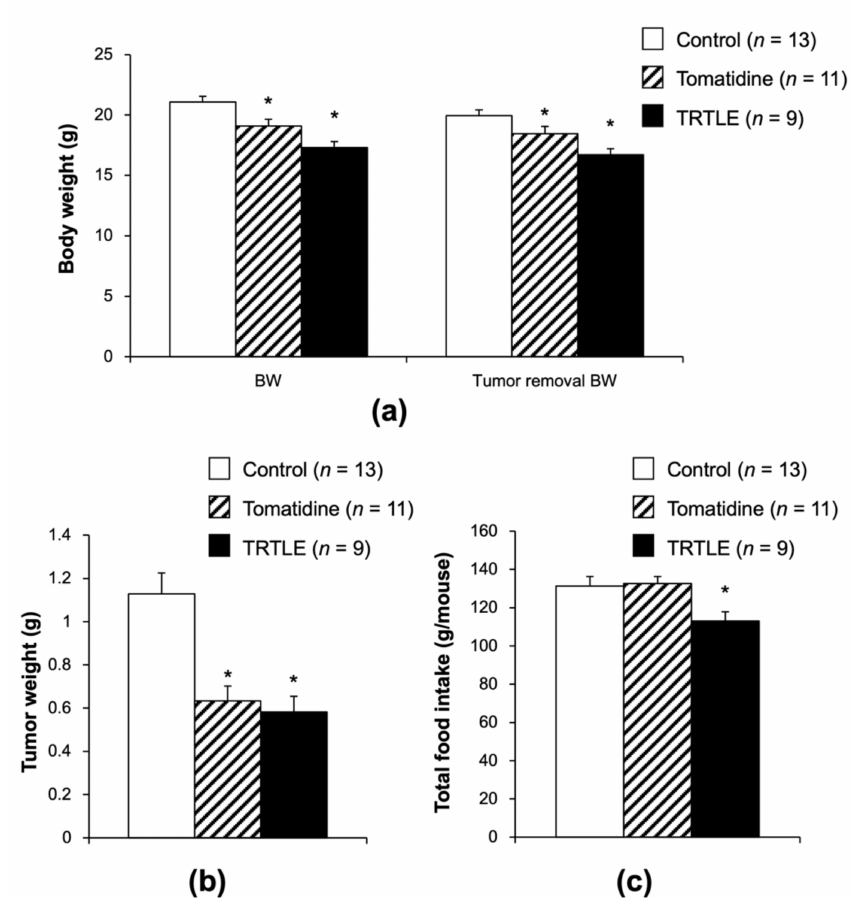
Figure 2. Effect of tomatidine and TRTLE on the tumor growth of an 85As2 syngeneic mouse model. Eight-week-old male BALB/c-AJcl-nu/nu mice were subcutaneously injected with 85As2 cells derived from human gastric cancer tissues. The mice were fed control diets (Control) or diets containing tomatidine (Tomatidine) or TRTLE (TRTLE) for 3 weeks. ( a ) Body weight (BW), BW after tumor removal (Tumor removal BW), and ( b ) tumor weight after 3-week experimental period are shown. ( c ) Total food intake during the 3 weeks of the experimental period is also shown. n = 9–13, means ± standard error (SE). * p < 0.05 vs.